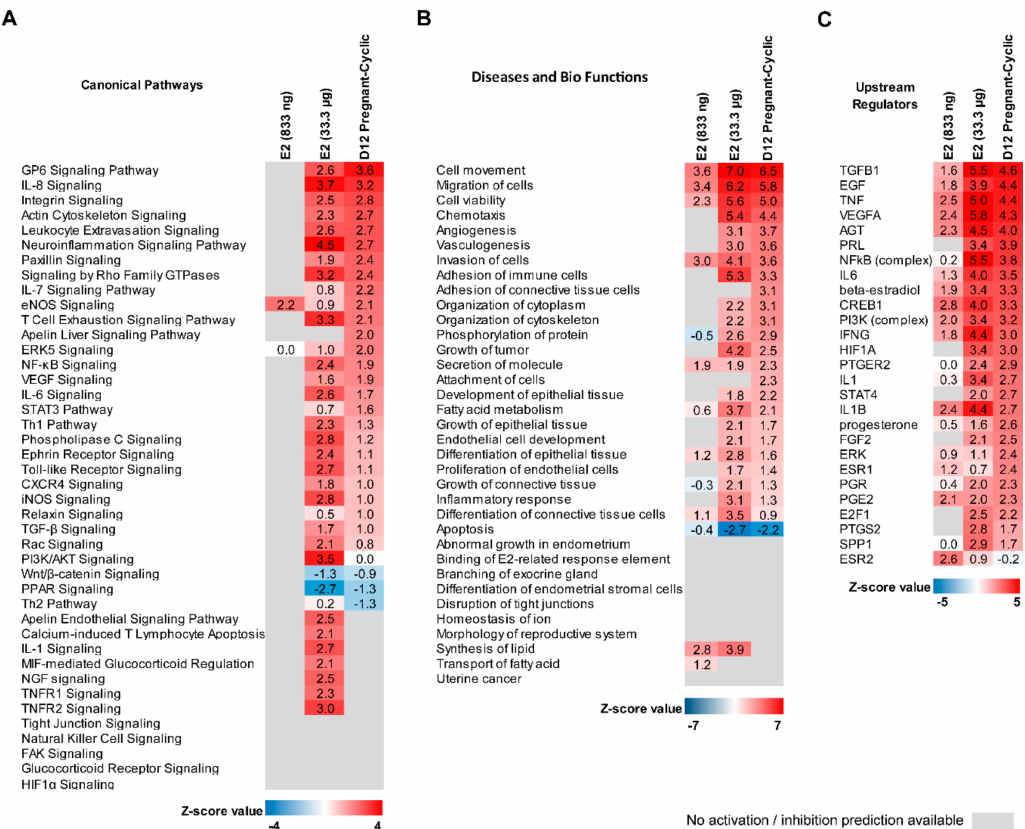
Figure 5. Comparison analysis of canonical pathways ( A ), diseases and bio functions ( B ) and upstream regulators enriched by DEGs identified in estradiol-17 β -treated (833 ng and 33.3 µ g / infusion) and day 12 of pregnancy endometrial samples. A Z-score value higher than 2 means that the enriched pathway ( A ) or enriched function ( B ) is significantly activated or stimulated, or the upstream regulator stimulates the set of identified DEGs ( C ). A Z-score value lower than 2 means that the enriched pathway ( A ) or enriched function ( B ) is significantly inhibited or suppressed, or the upstream regulator suppresses the set of identified DEGs ( C ). Grey color indicates there is no data allowing for activation / suppression or stimulation / inhibition prediction of the enriched